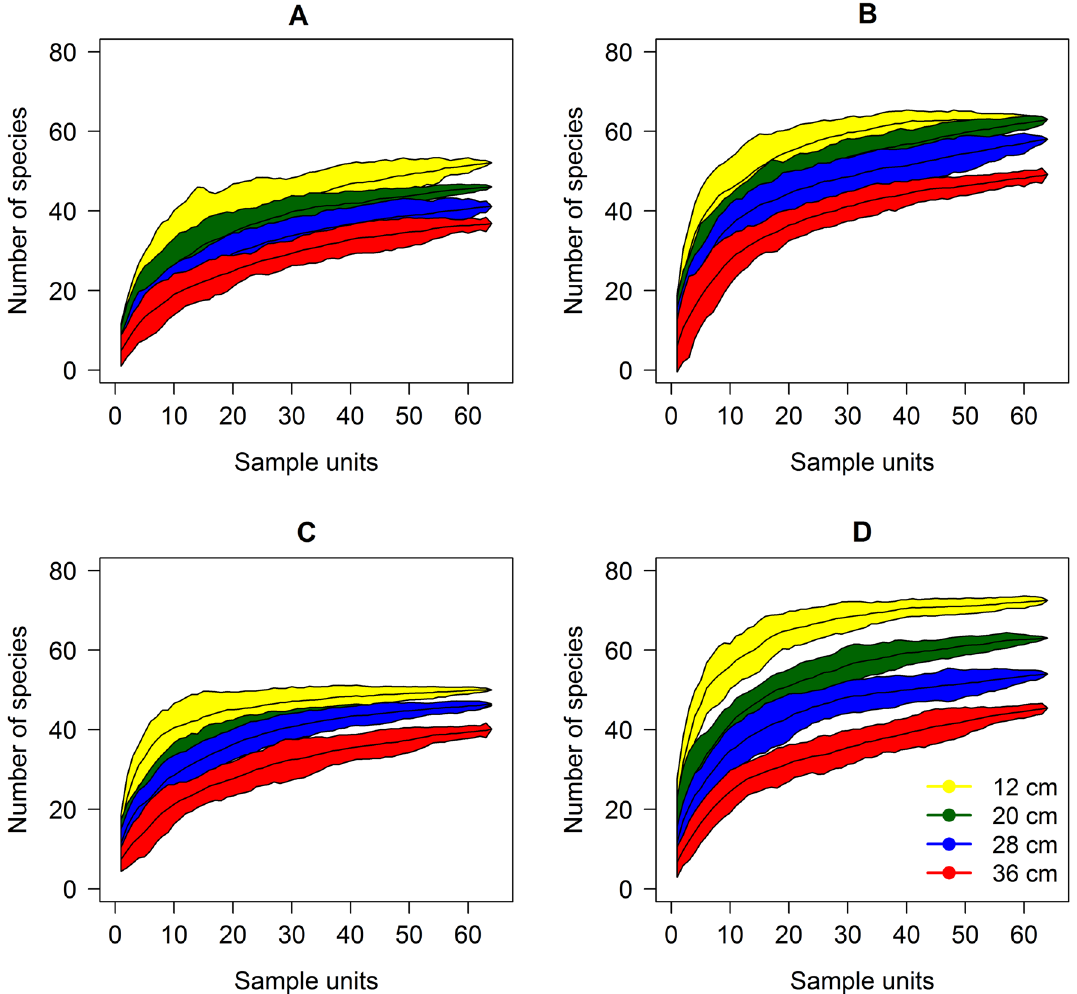
Figure 1. Species accumulation curves in a Highland grassland dominated by Andropogon lateralis Nees managed under different canopy heights. Evaluation seasons: autumn 2016 ( A ), spring 2016 ( B ), autumn 2017 ( C ), and spring 2017 ( D ). The number of species was considered distinct among canopy heights when confidence intervals of the species accumulation curve did not overlap. This figure was created by the authors using the R environment version 4.1.0 (https:// www.R- proje ct. org/) and the vegan package version 2.5-7 (https:// CRAN.R- proje ct. org/ packa ge= vegan).